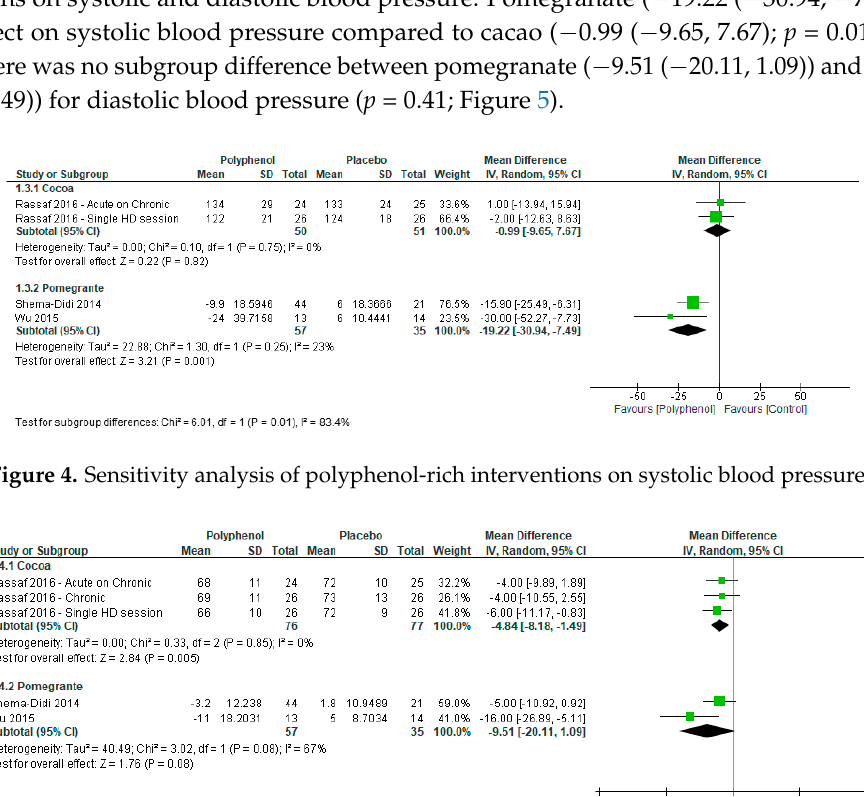
Figure 5. Forest plot of polyphenol-rich interventions on diastolic blood pressure.